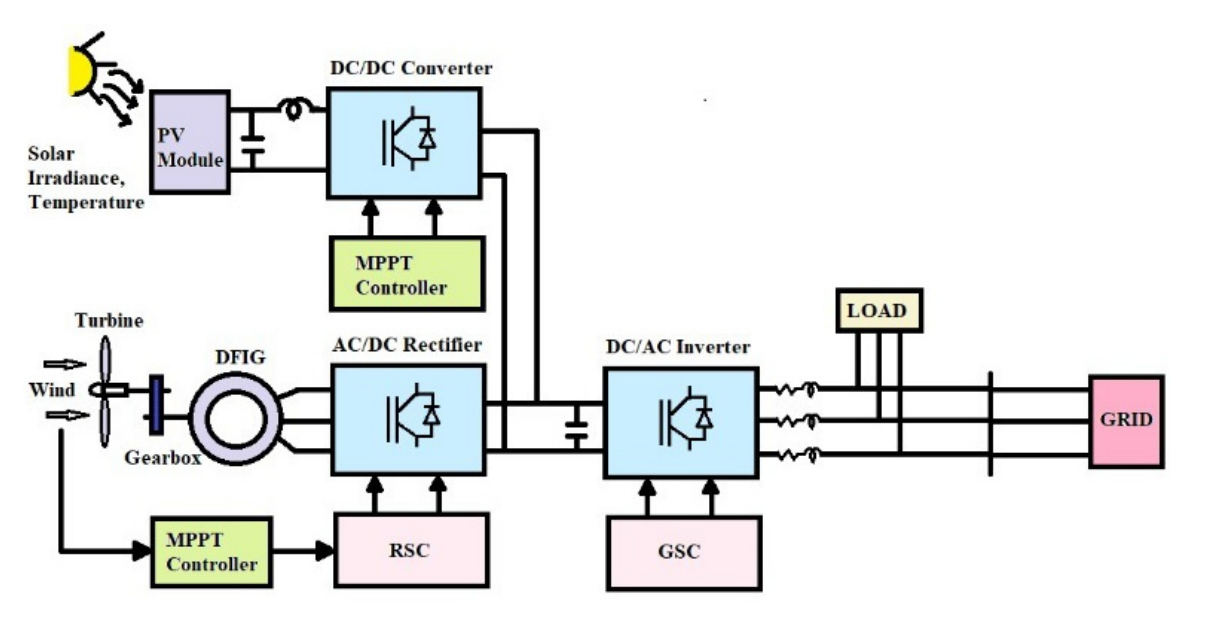
Figure 3. Wind/PV hybrid System.